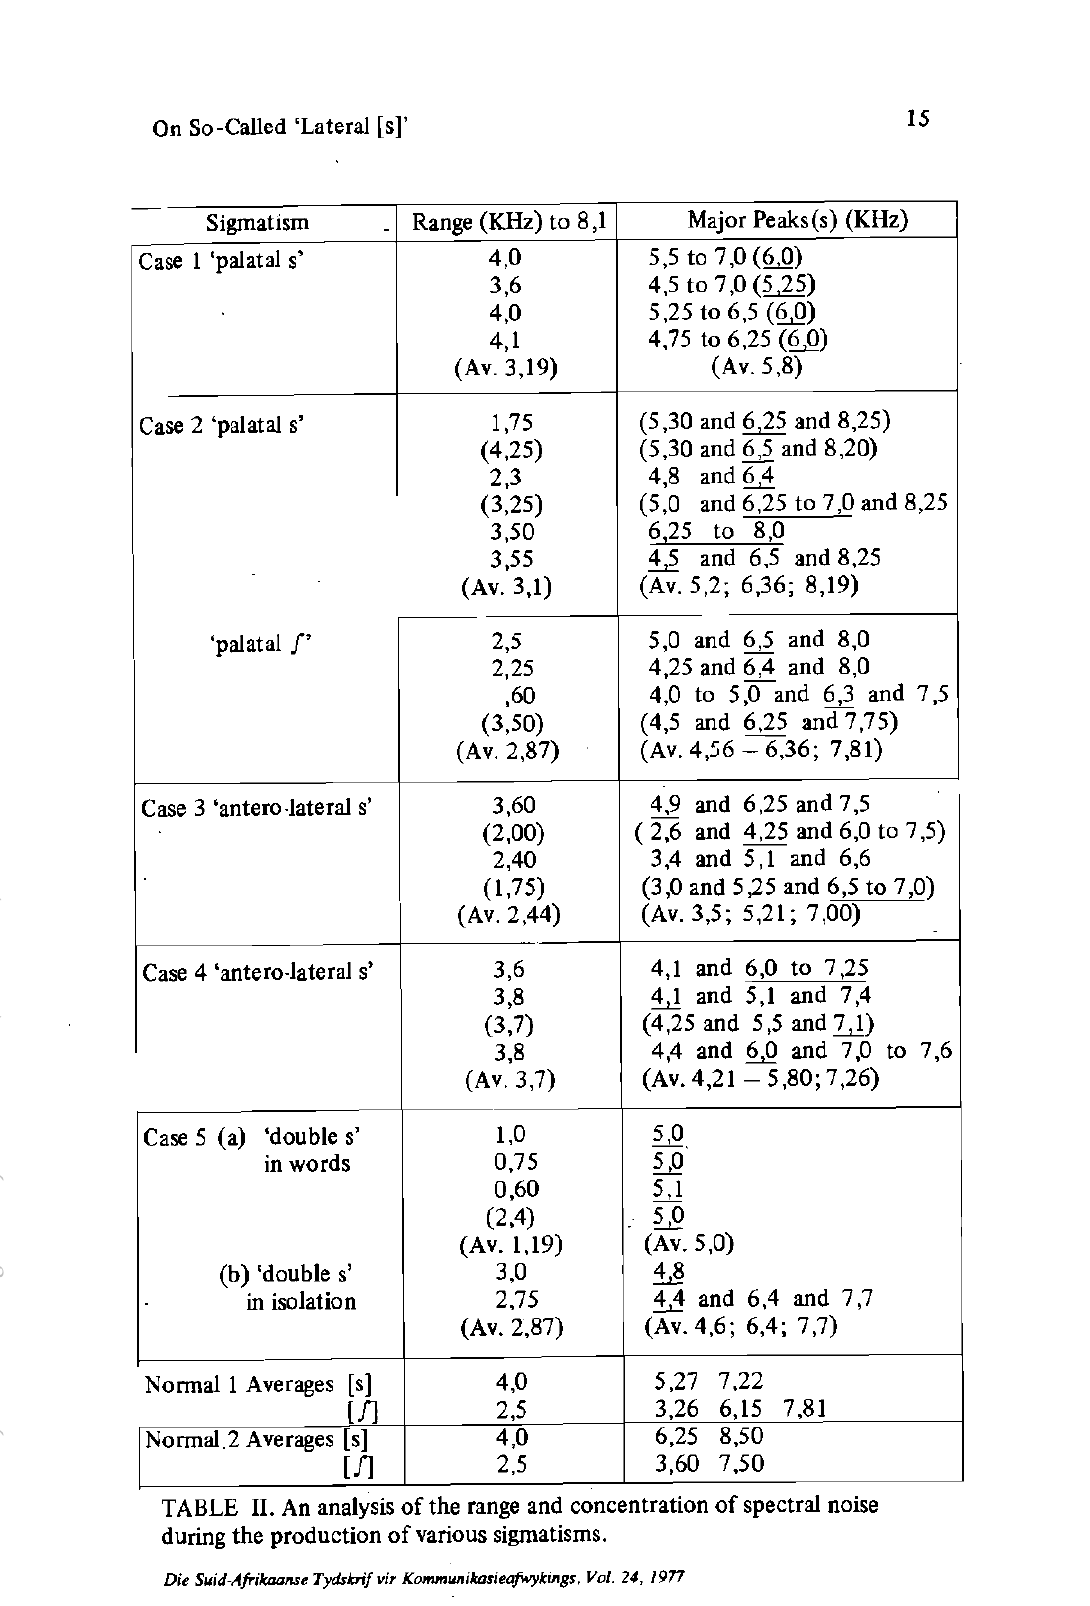
TABLE II. An analysis of the range and concentration of spectral noise during the production of various